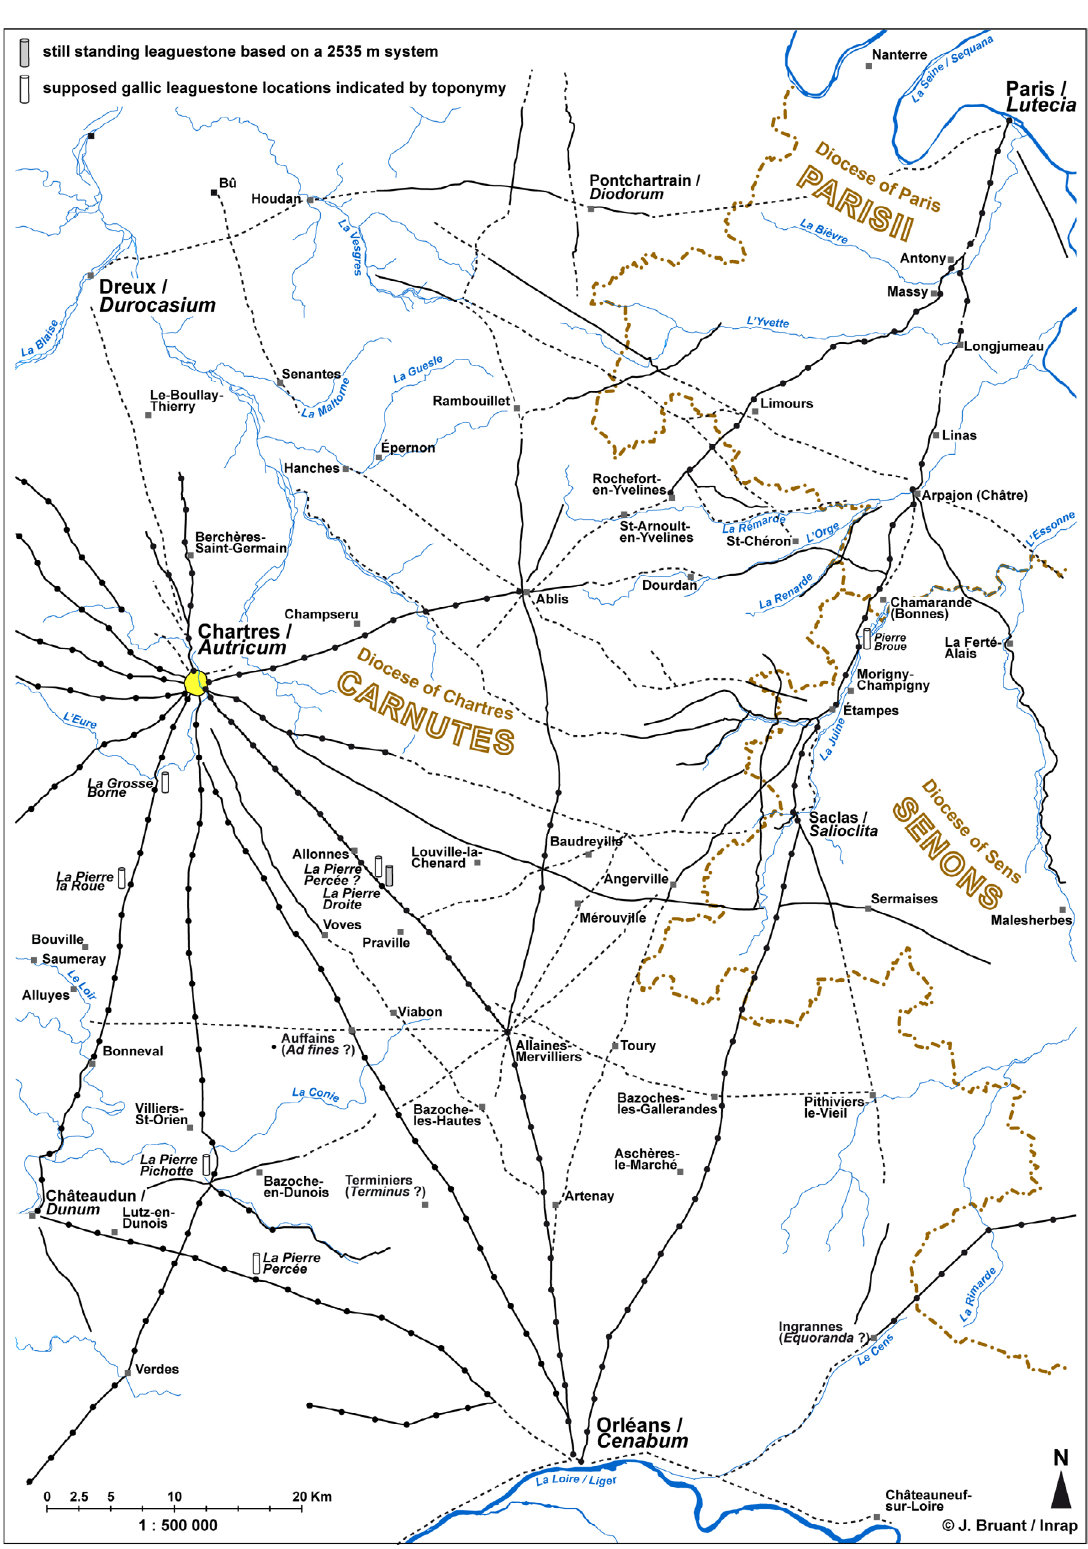
Figure 24. Presumed leaguestone location (2535 m) on the network of roads between Orleans/ Cenabum , Paris/ Lutecia and Chartres/ Autricum . © J.